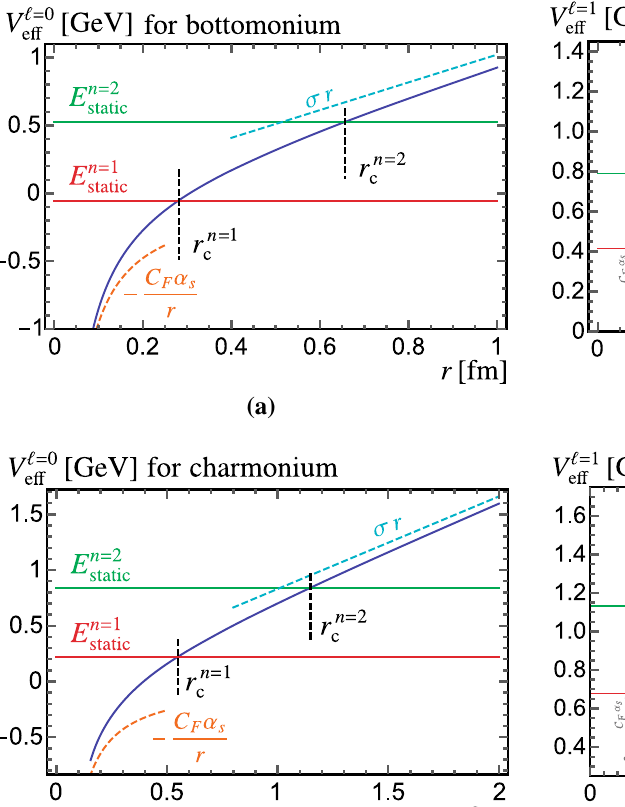
vertical, black, dashed lines. We also show the asymptotic behavior for large r in dashed cyan, and the small r dominant terms in dashed orange (Coulombic for left plot and centrifuge for right plot), and for the right plots the Coulombic plus centrifuge terms added together, in dashed gray